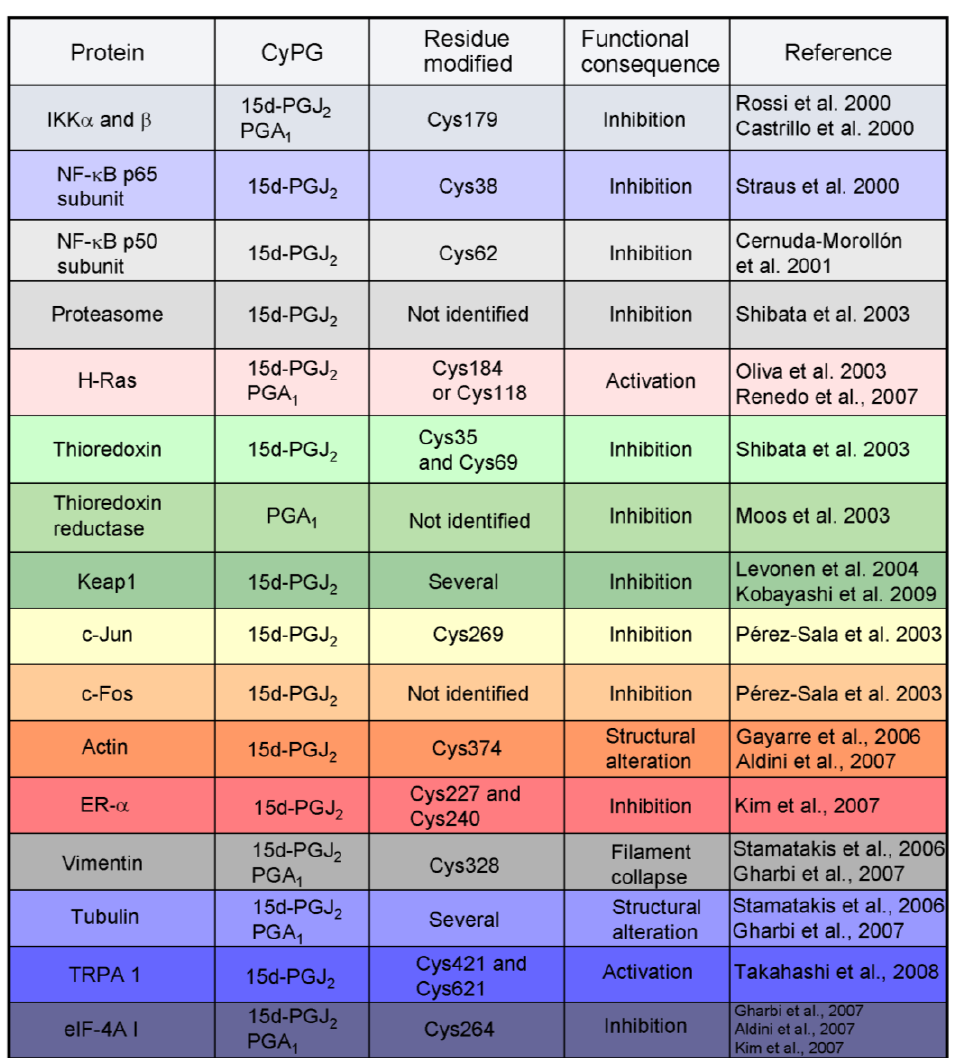
FIGURE 4. Summary of several protein targets for covalent modification by cyPG. Among the protein targets for covalent modification by cyPG characterized are transcription factors, receptors, and proteins involved in redox control and in protein synthesis and degradation, among